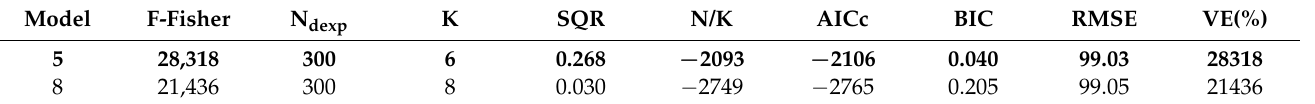
Table 9. Goodness-of-fit statistical data at 95% confidence for the proposed kinetic models fitted to the L-L-S triphasic glycerol (+water)-toluene (+ibuprofen)-N435 data (fitting each model to all retrieved data). In bold font we observed the statistical parameters for the selected kinetic